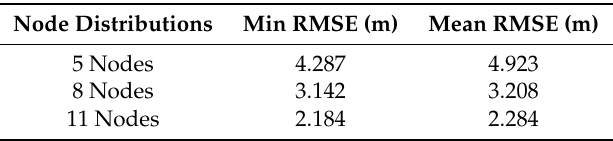
Table 6. MA optimization results. Values displayed are the mean and minimal values of the mean RMSE of the simulations executed.